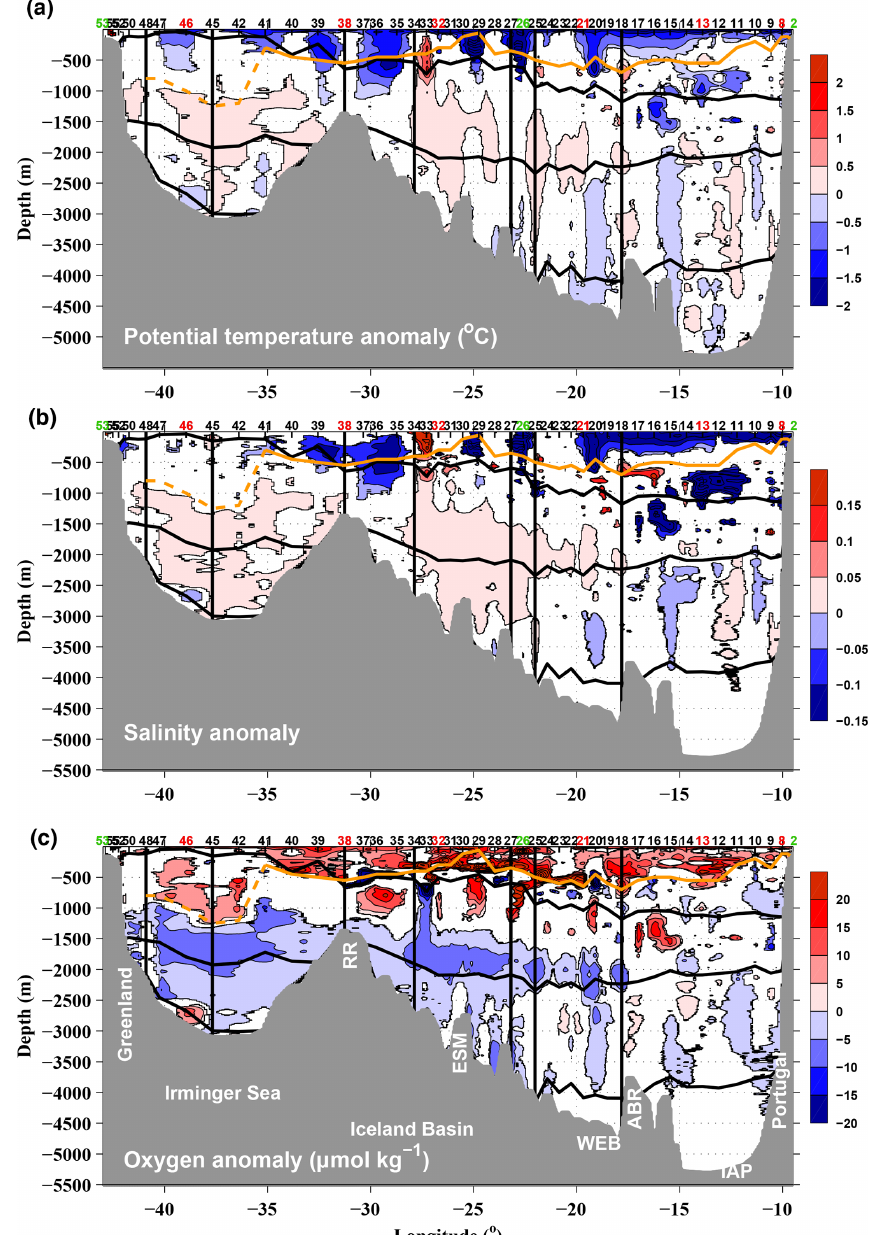
Figure 7. Anomalies of potential temperature ( a ; in ◦ C), salinity ( b ), and oxygen ( c ; in µmolkg − 1 ) in 2014 with respect to the OVIDE 2002–2012 mean. Only anomalies larger than 1 standard deviation of the 2002–2012 values are colored in the figure. Station numbers follow the color code of Fig. 2. The orange line indicates the winter mixed layer depth (WMLD); in the Irminger Sea, the dotted line indicates the WMLD that was not formed locally (see Sect. 4.2). The acronyms in panel ( c ) are as in Figs. 2 and